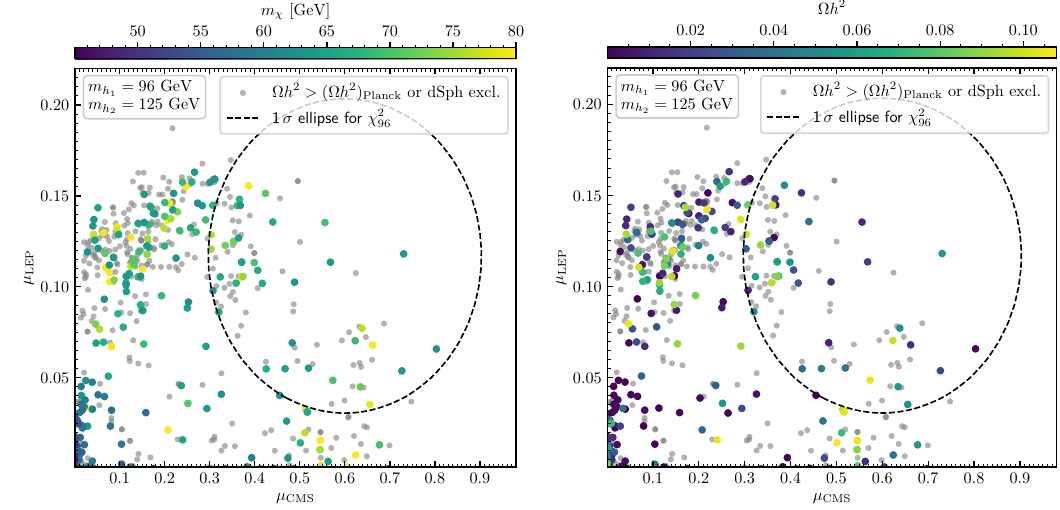
Figure 6 . µ LEP in dependence of µ CMS , with the colour coding indicating the values of m χ (left) and Ω h 2 (right). Grey points are excluded by Ω h 2 > (Ω h 2 ) Planck or Fermi dSph measurements. The dashed ellipse indicates the experimentally preferred region of the collider excesses at the 1 σ confidence